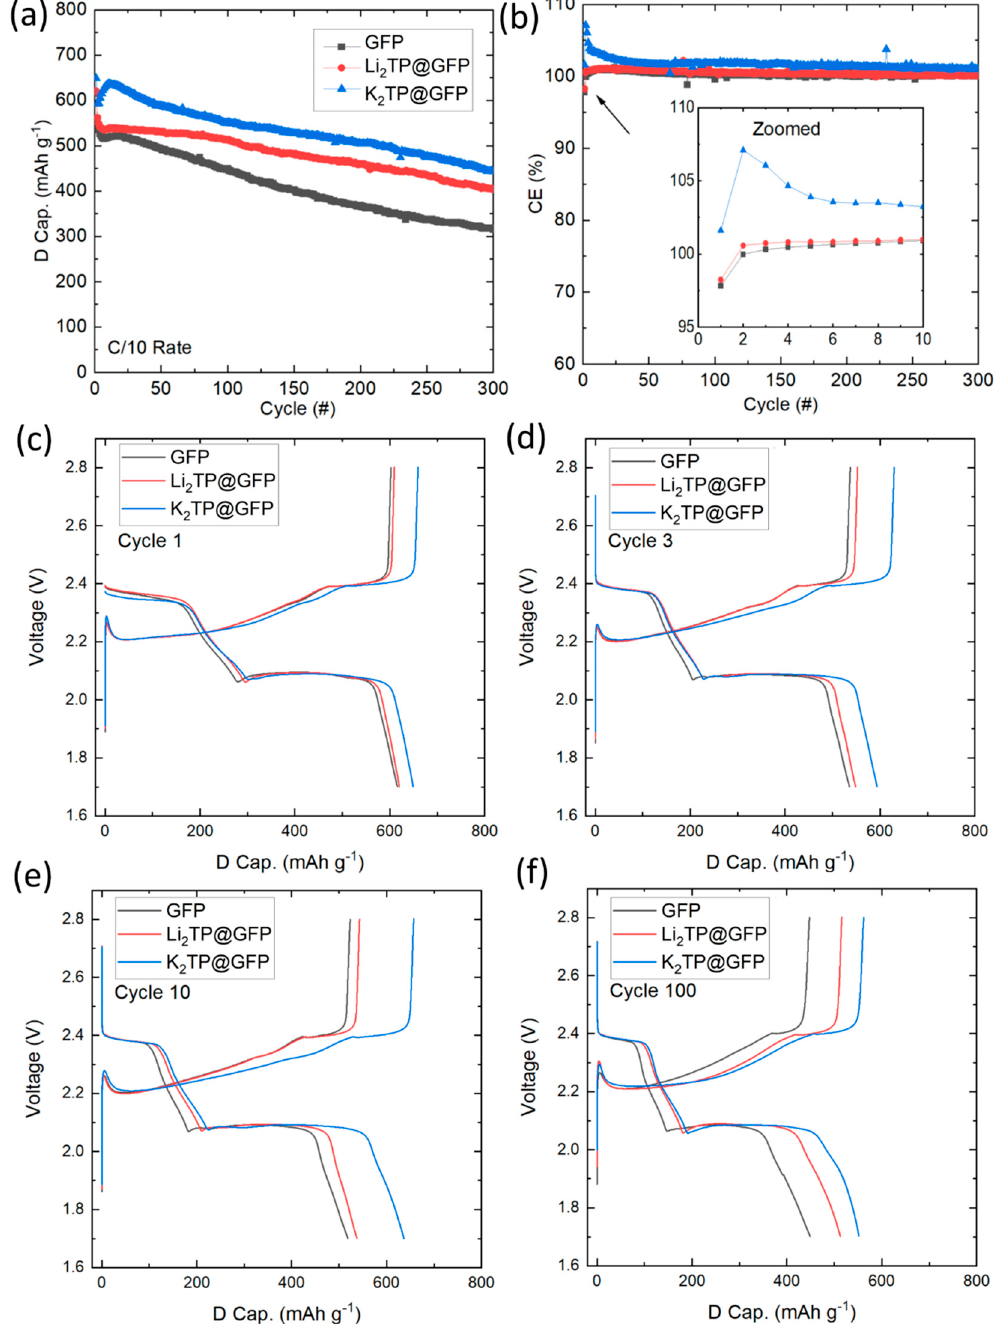
Figure 4. ( a ) C/10 cycling and ( b ) CE of LSBs with modified and modified separators, as well as select voltage profiles from cycles ( c ) 1, ( d ) 3, ( e ) 10, and ( f ) 100.